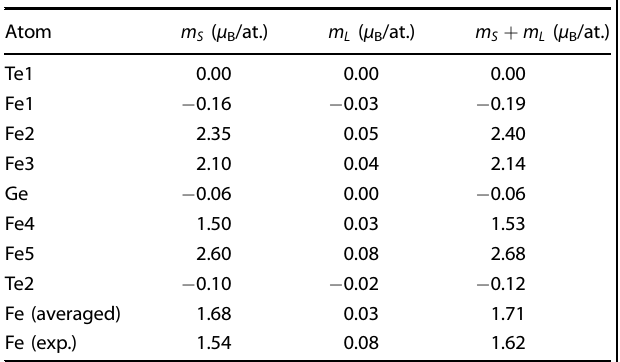
Table 1. Estimated magnetic moments of Fe 5 GeTe 2